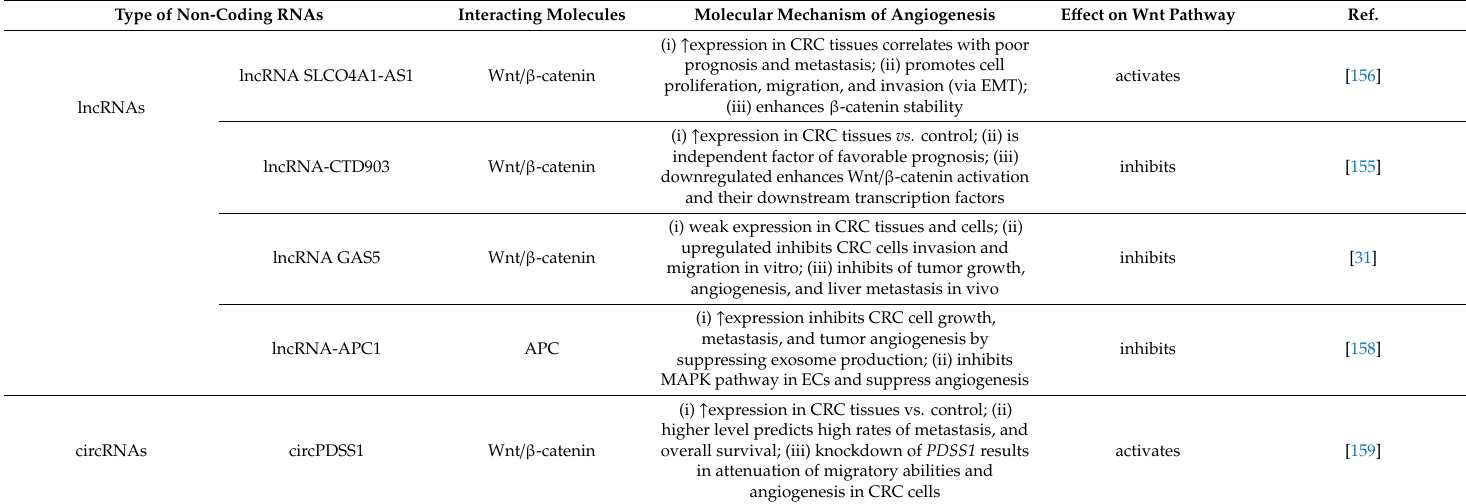
proliferation, migration, and invasion (via EMT); (iii) enhances β -catenin